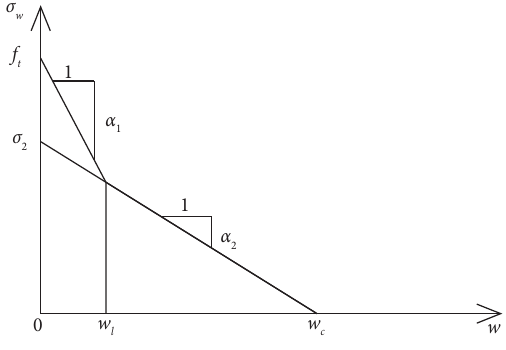
Figure 12: Bilinear stress-crack opening relationship. Table 7: Te specifc values of material parameters of beams.